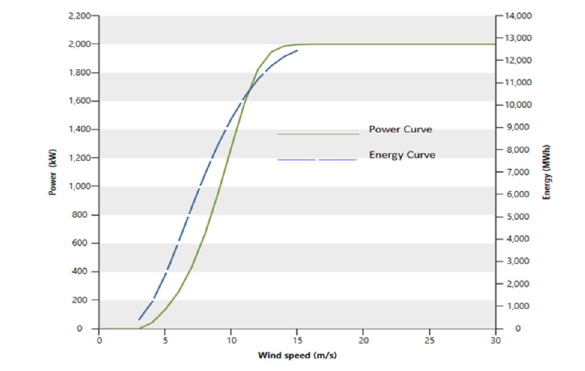
Fig. 3: Energy curve ff Vesta V80-2.0